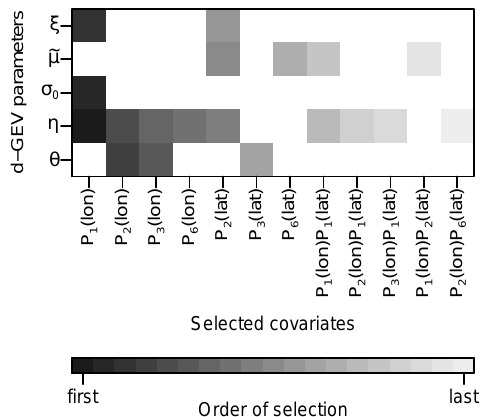
Figure 2. Final model selection result. For each d-GEV parameter, the added covariates are shown as colored boxes, according to the order of their